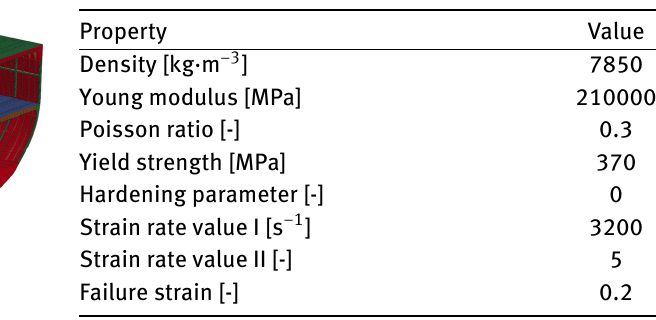
Table 2: Material model in collision